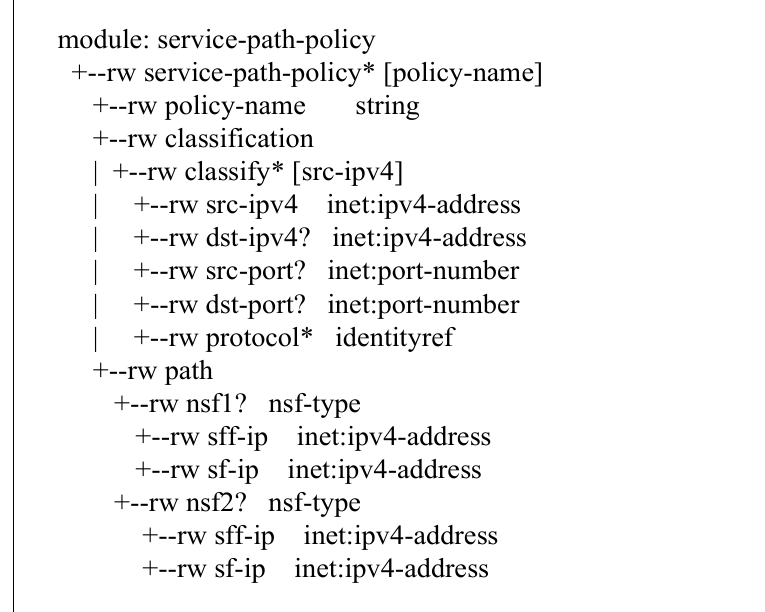
Figure 7. Information Model for Low ‐ Level Path Policy.